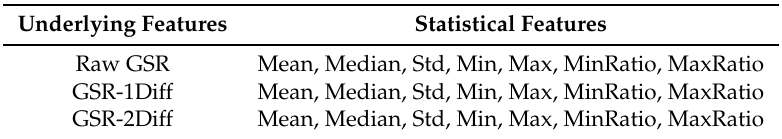
Table 2. Features extracted from GSR signal.